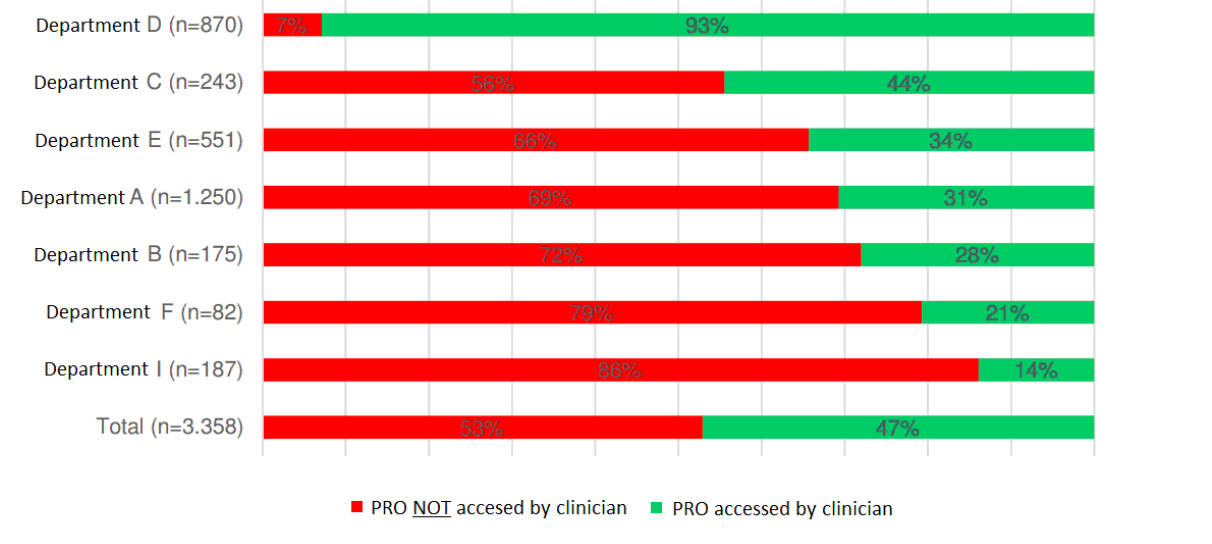
Figure 8. The proportion of PRO questionnaires that was viewed by a clinician during the follow-up visit of patients treated for lung cancer in seven Danish oncological departments (translated from Danish [34]). PRO: patient-reported